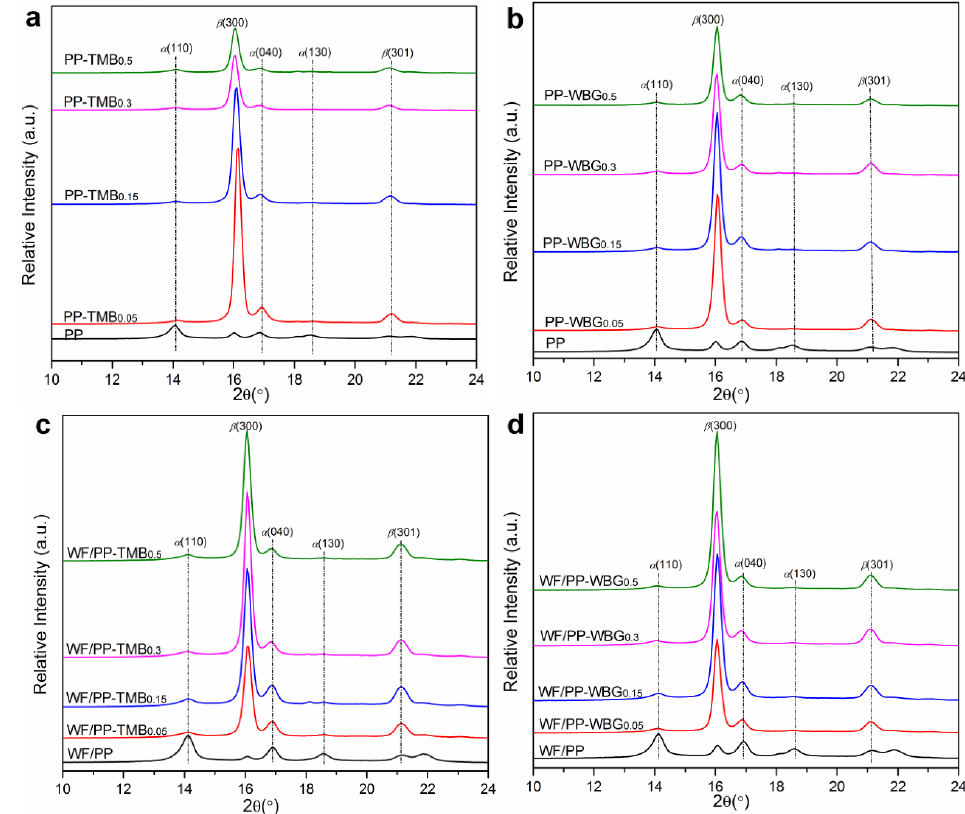
Figure 2. WAXD spectra of pure PP, ( a ) PP-TMB, ( b ) PP-WBG, ( c ) WF/PP-TMB, and ( d ) WF/PP-WBG containing varying concentrations of TMB5 or WBG II.